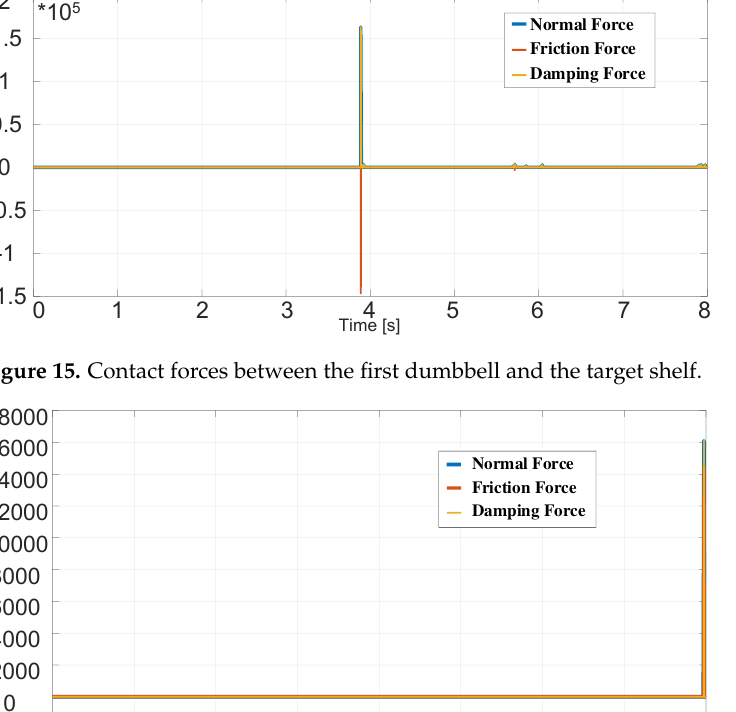
Figure 14. Contact forces between the second finger and the second dumbbell.